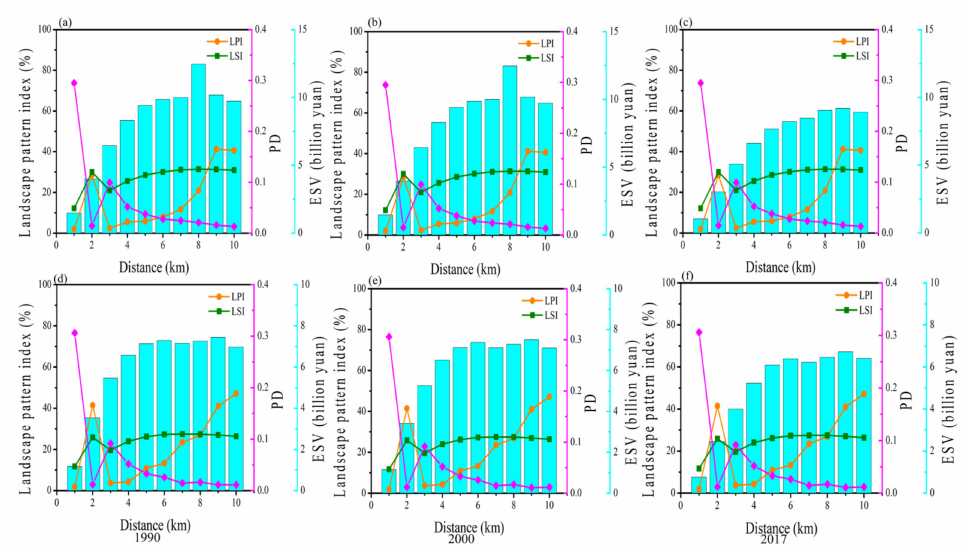
Figure 6. Landscape index and ESVs changes in ( a – c ) expressway entrance buffer zone, ( d – f ) exit and train station buffer zone.